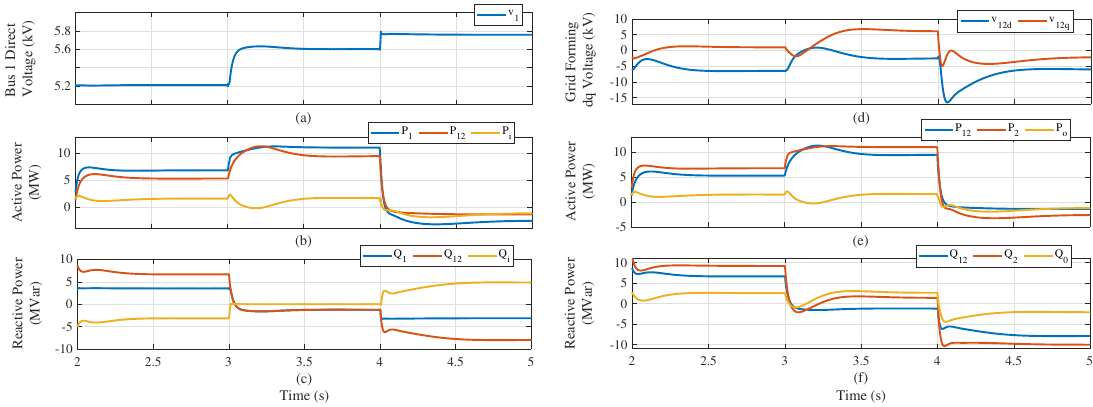
Figure 12. ( a ) Direct voltage at bus 1. ( b ) Active power flows in the shunt port. ( c ) Reactive power flows in the shunt port. ( d ) v 12 direct and quadrature components. ( e ) Active power flows in the series port. ( f ) Reactive power flows in shunt port.